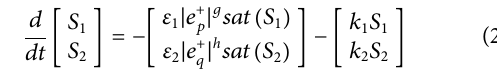
FIGURE 4 | Four-terminal MMC-based DC power system.